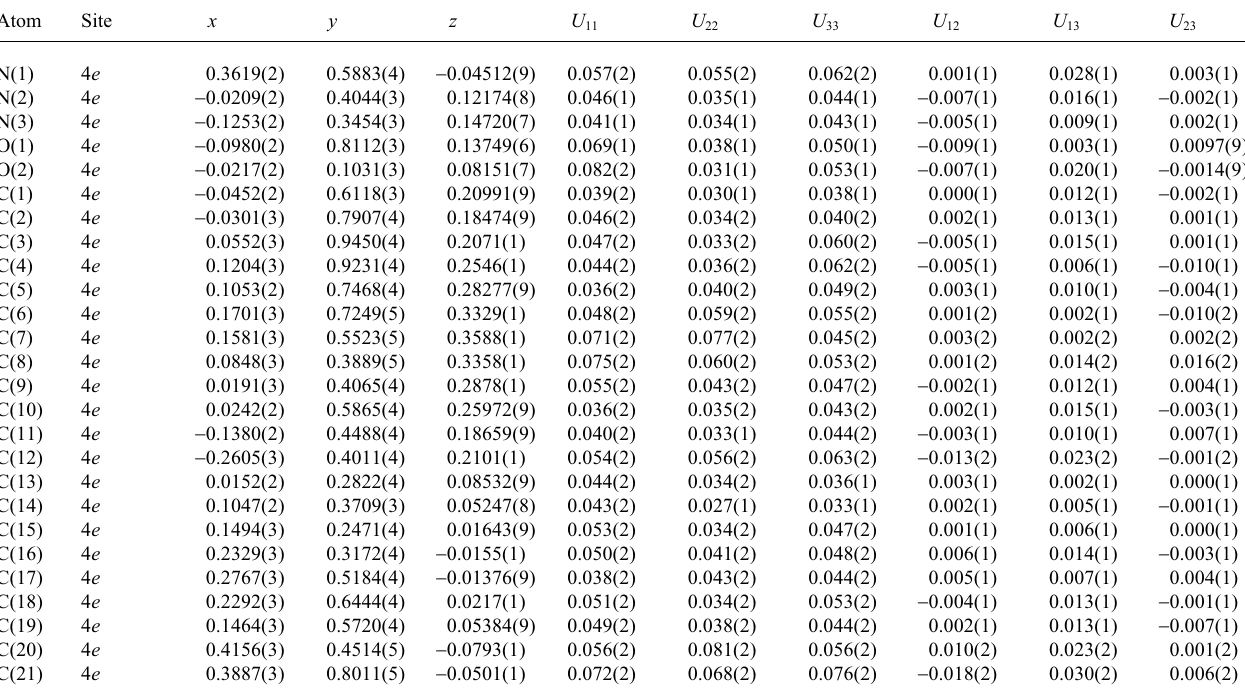
Table 3. Atomic coordinates and displacement parameters (in Å 2 )